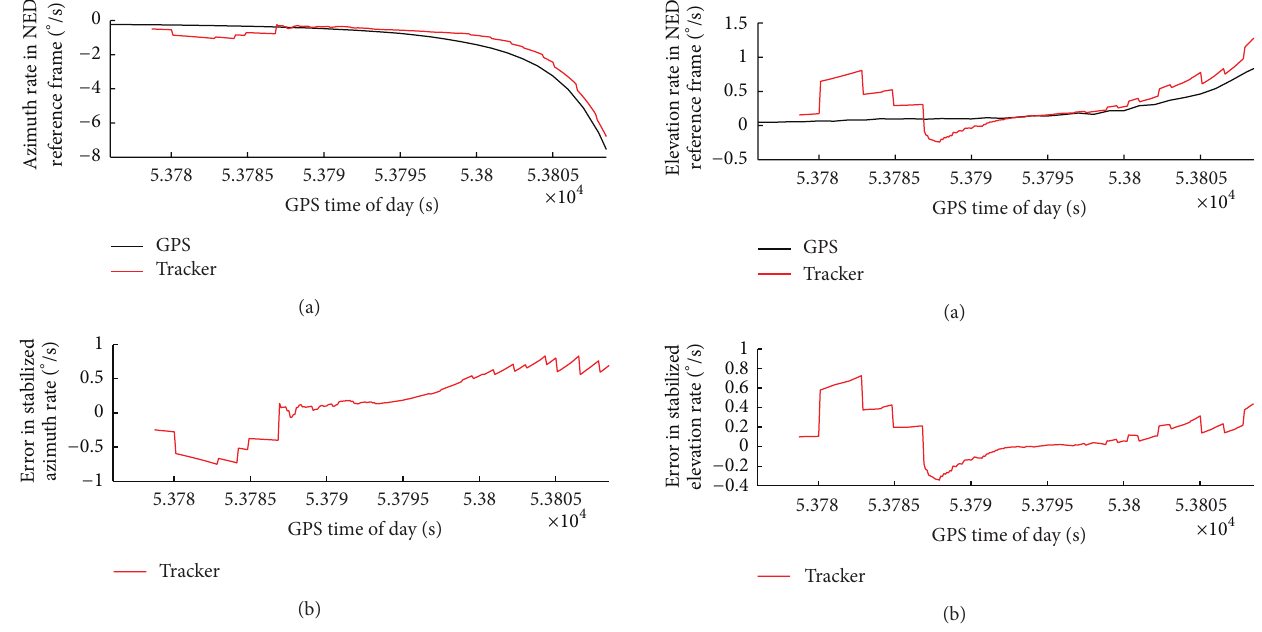
Figure 15: Intruder elevation rate in NED (GPS and tracker) and relative estimation error (tracker with respect to GPS) as a function of GPS time in the considered scenario.